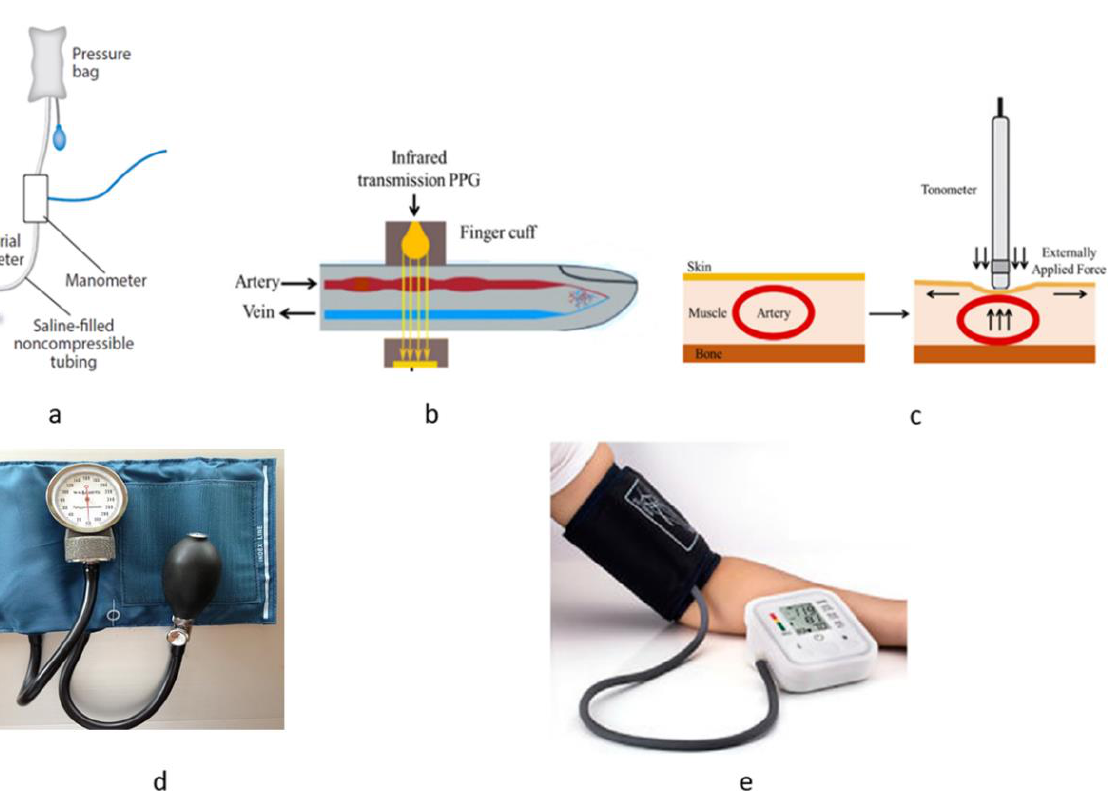
Figure 2. Traditional methods of BP measurement techniques. ( a ) arterial catheterization method, ( b ) vascular unloading technique, ( c ) arterial tonometry method, ( d ) auscultation method, ( e ) oscillometric method [19,43] CC by 4.0.